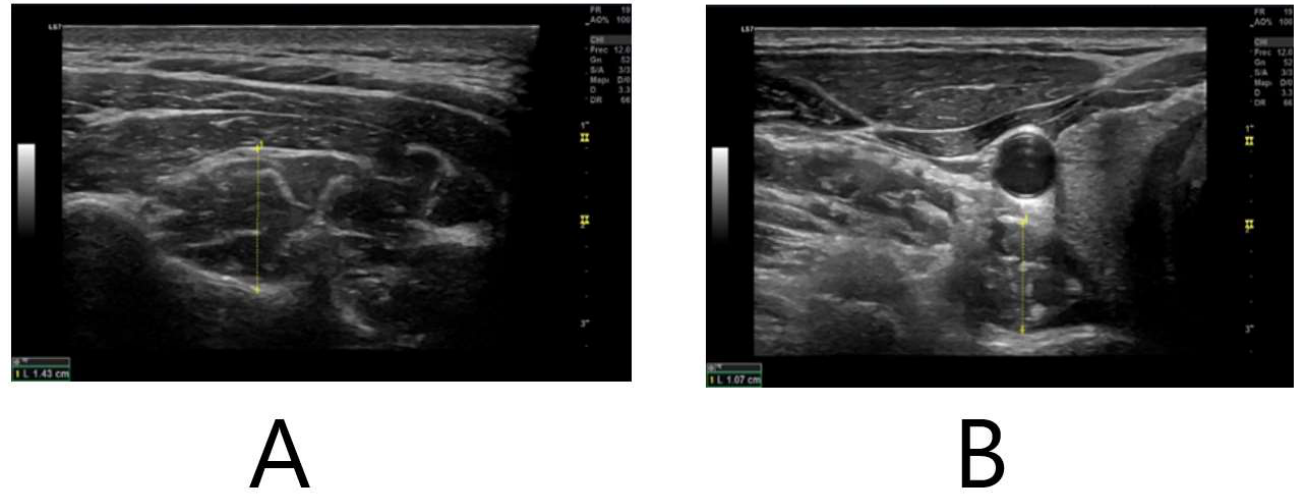
Figure 1. Ultrasound assessment of deep cervical muscles. ( A ) Ultrasound image of the multifidus in transverse view at C5. The caliper is placed 90 ⁰ to the lamina of C5 where the rater considered the muscle to be at its thickest and up to the echogenic line of the hyperechoic fascia between the semispinalis cervicis and semispinalis capitis. ( B ) Ultrasound image of the longus colli at C6 transverse view. The caliper is placed on the midpoint of the ventral surface of the C6 vertebral body and the interface between the Lcol and the pre-fascial tissue surrounding the carotid artery.